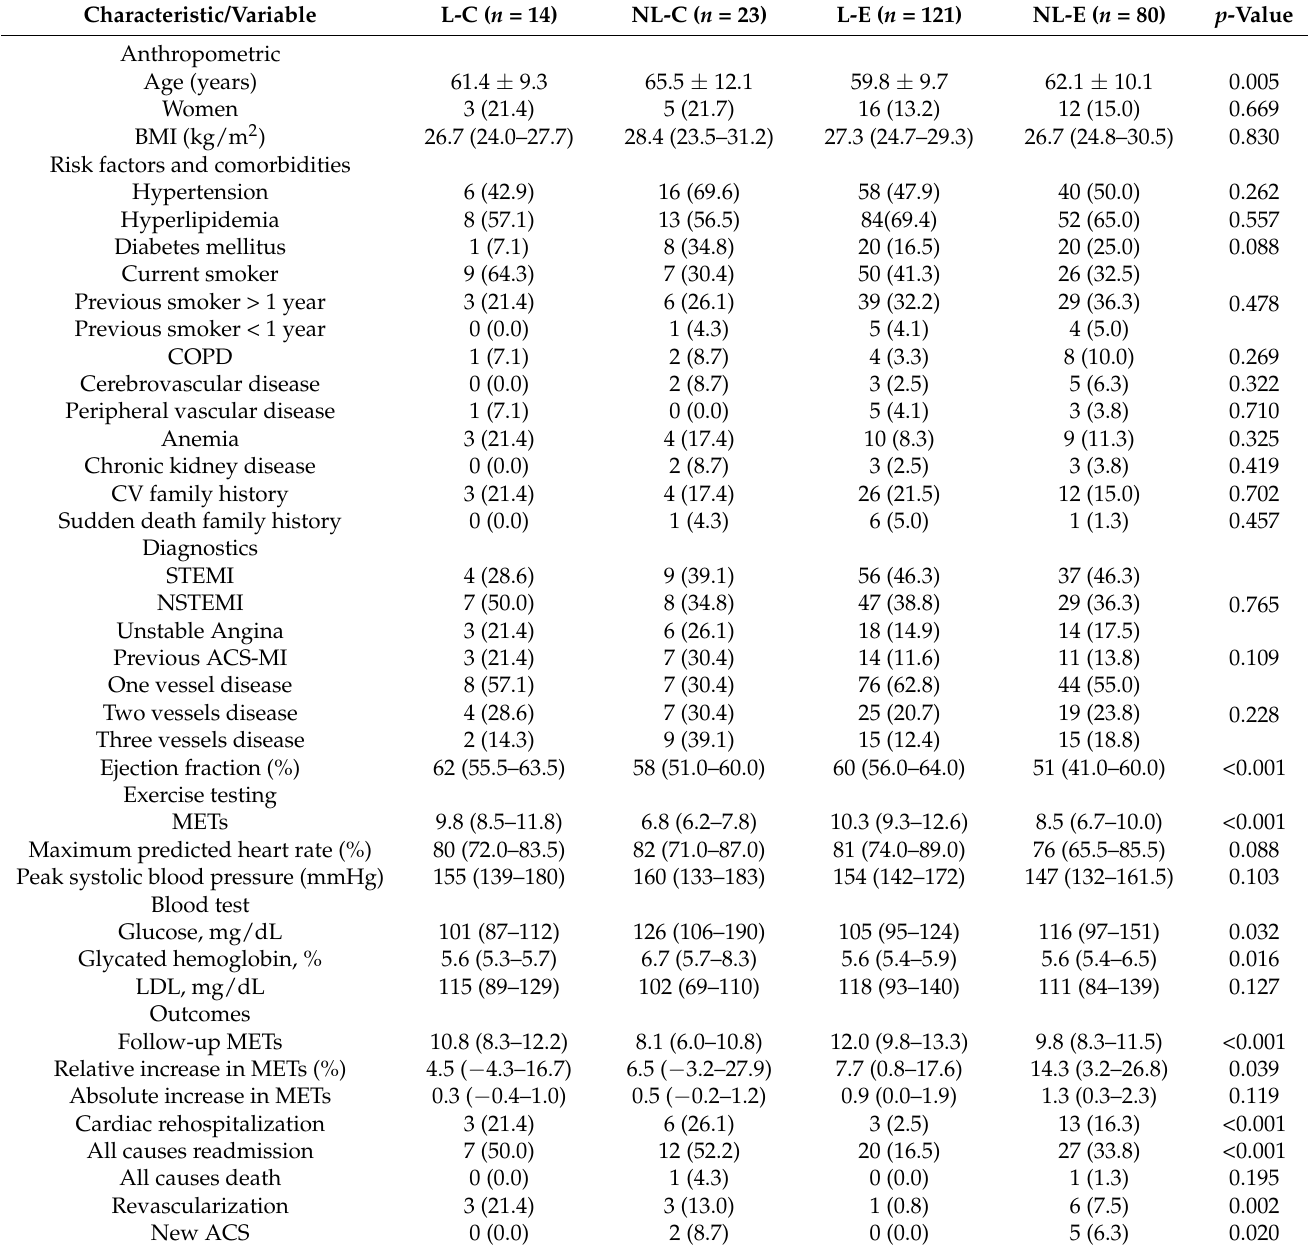
Table 4. Baseline characteristics according to risk stratification and exercise training